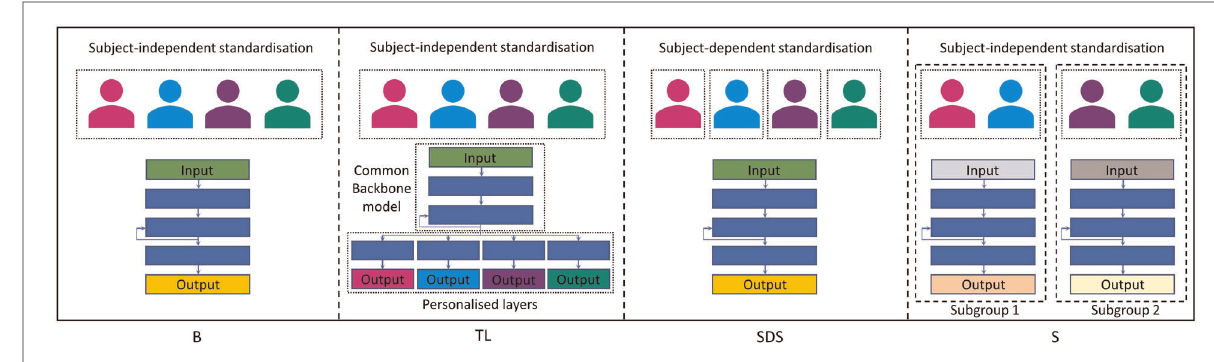
FIGURE 4 Simpli fi ed overview of our (B)aseline model as well as of the three personalisation approaches used in our experiments: (T)ransfer (L)earning with shared common layers, (S)ubject-(D)ependent (S)tandardisation, and (S)ubgroup